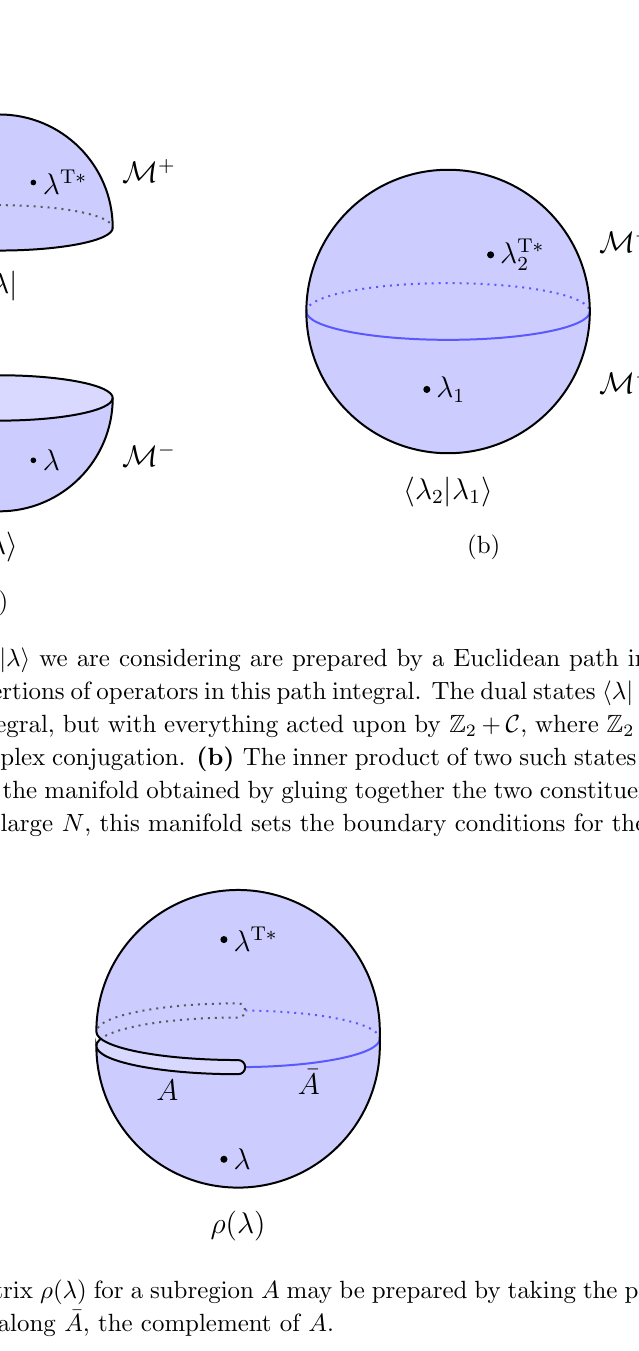
M (cid:0) ), and (cid:21) T (cid:3) ( (cid:28); x ) for (cid:28) > 0 (i.e. on M + ). Here the superscript T denotes a time re(cid:13)ec- 2 tion, so (cid:21) T (cid:3) ( (cid:28); x ) = (cid:21) (cid:3) ( (cid:0) (cid:28); x ). In this paper, unless stated otherwise, all bulk actions are 2 2 Euclidean. Figure 4 contains an illustration of the path integrals for j (cid:21) i , h (cid:21) j and h (cid:21) We will use (cid:30) to denote the collection of bulk (cid:12)elds dual to boundary operators. It was shown in [50] that, at leading order in large N , the Berry curvature for normalised states of the above form matches exactly with the symplectic form of the bulk (cid:12)elds, where bulk (cid:12)eld variations (cid:14)(cid:30) are related with changes in boundary sources (cid:14)(cid:21) via the holographic dictionary.